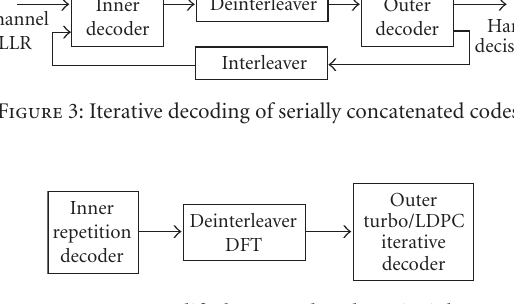
Figure 4: Modified OFDM decoder principle.